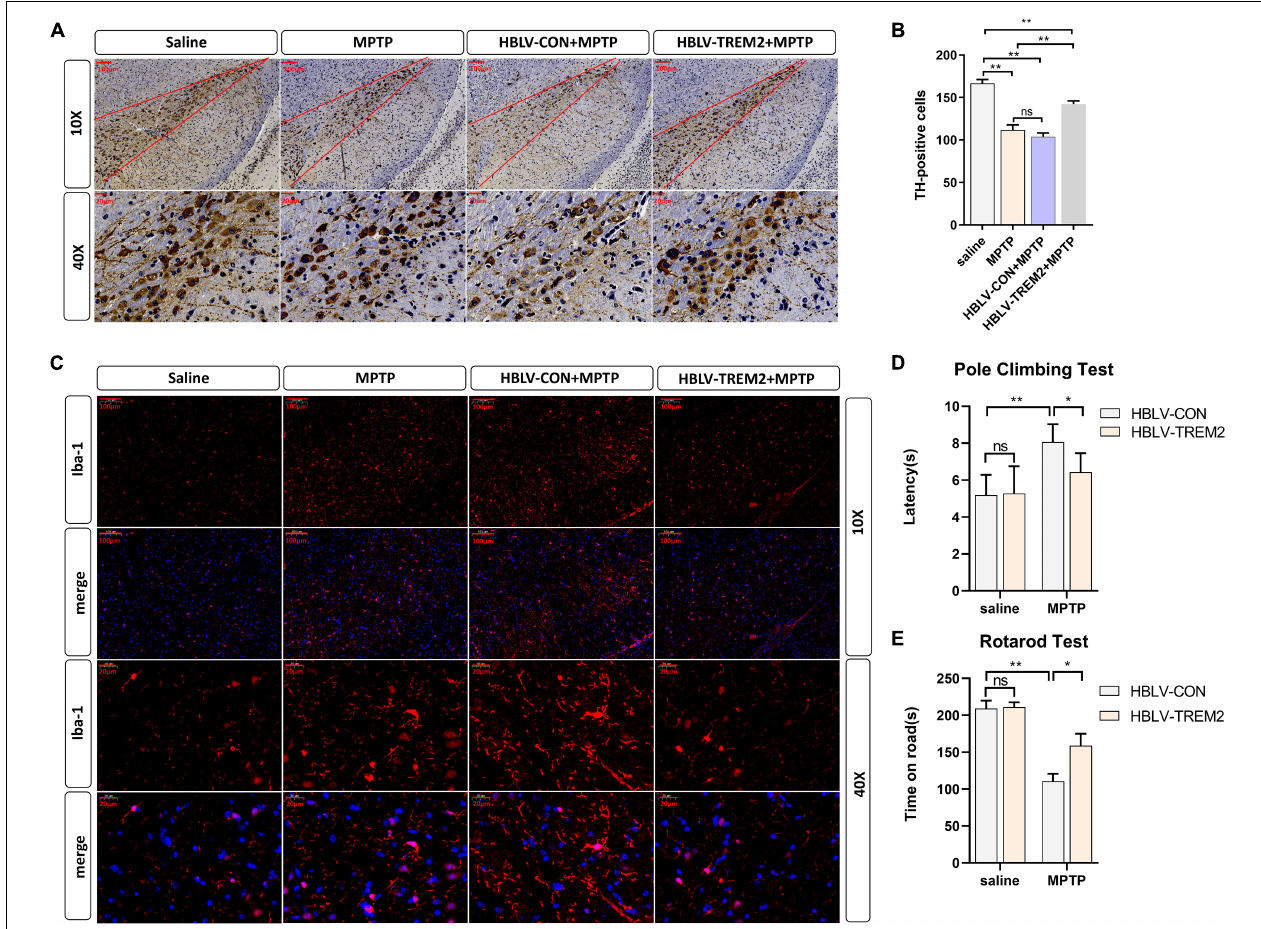
FIGURE 6 | Overexpression of TREM2 can inhibit the activation of microglia, reduce the damage to DA neurons, and improve the motor ability of MPTP-treated mice. The mice were subjected to stereotactic intraventricular treatment with HBLV-TREM2 or NC and then received 1 intraperitoneal injection of MPTP-HCl per day for 5 days. The HBLV-TREM2 treatments were performed 7 days prior to the MPTP injection. At the same time, mice that were not injected with the HBLV-TREM2 or NC received MPTP-HCl injections, and the control mice received saline injections. Then, the mice were decapitated, and the midbrain was obtained 7 days after the last MPTP injection. (A) Immunostaining of tyrosine hydroxylase (TH)-positive neurons in the SNPC is shown (n = 3/group). Scale bar: 100 µ m and 20 µ m. (B) The number of TH cells in the SNpc (the area between two red lines) were manually counted ( F = 109.2). (C) Immunofluorescence images confirmed the expression of Iba-1 ( n = 3/group). Red: anti-Iba1 (antibody labeling microglia). Scale bar: 100 µ m and 20 µ m. (D,E) The pole-climbing test and rotarod test for bradykinesia were performed on 7th day after the last MPTP injection ( n = 12/group). All the quantitative analysis of protein was done by Image J to calculate the gray value. Data are shown as the mean ± SE. The fold change is significant where * P < 0.05, **P < 0.01. n = number of